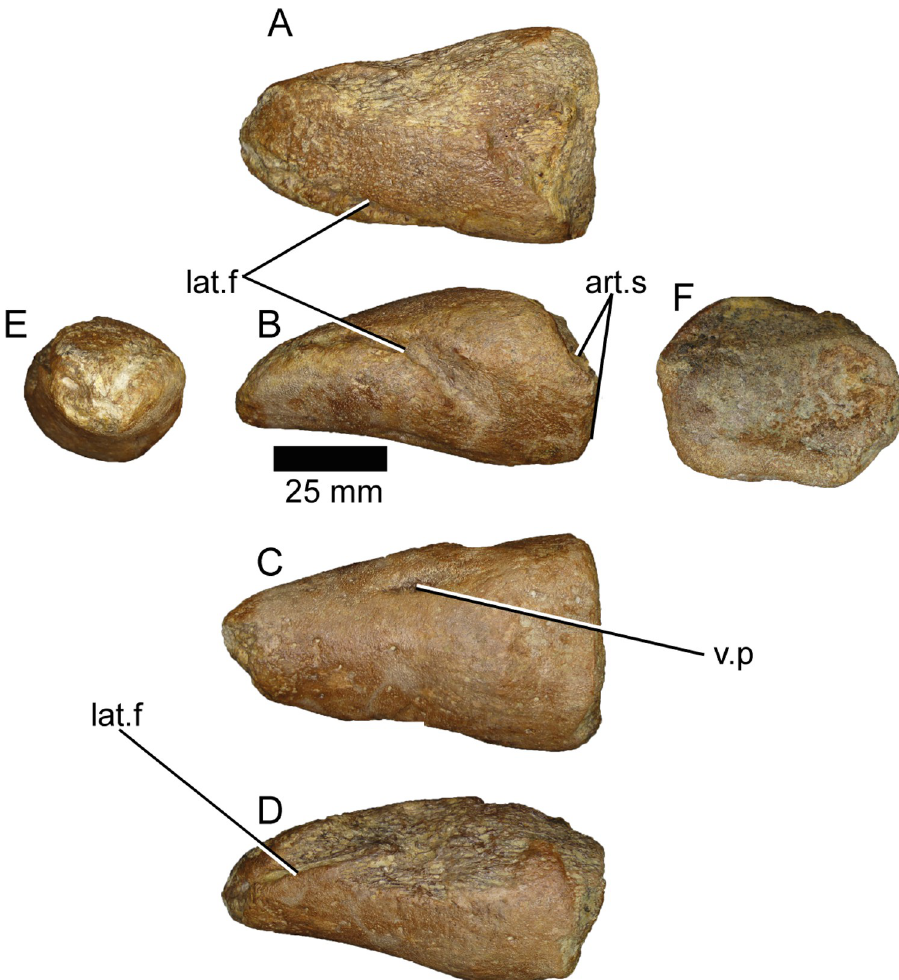
Fig 25. Pedal ungual phalanx of Iberospinus natarioi (ML1190-34). A , dorsal, B, D; lateral, C , ventral, E , proximal, and F, distal view. art.s , articular surface, lat.f , lateral furrows, v.p , ventral